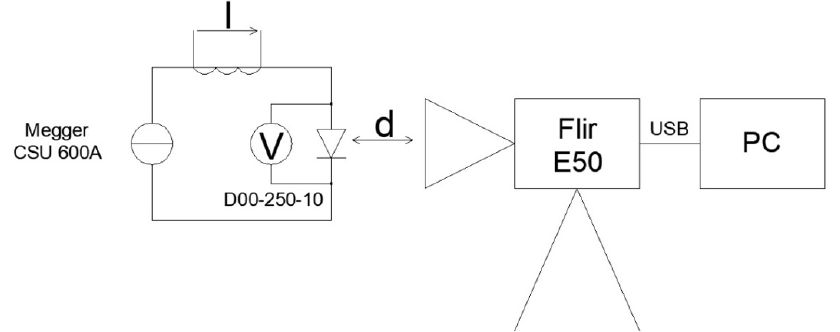
Figure 2. Scheme of the measuring system; d— distance between observed diode and thermographic camera lens (bigger than Flir E50 minimum focus distance in meters).